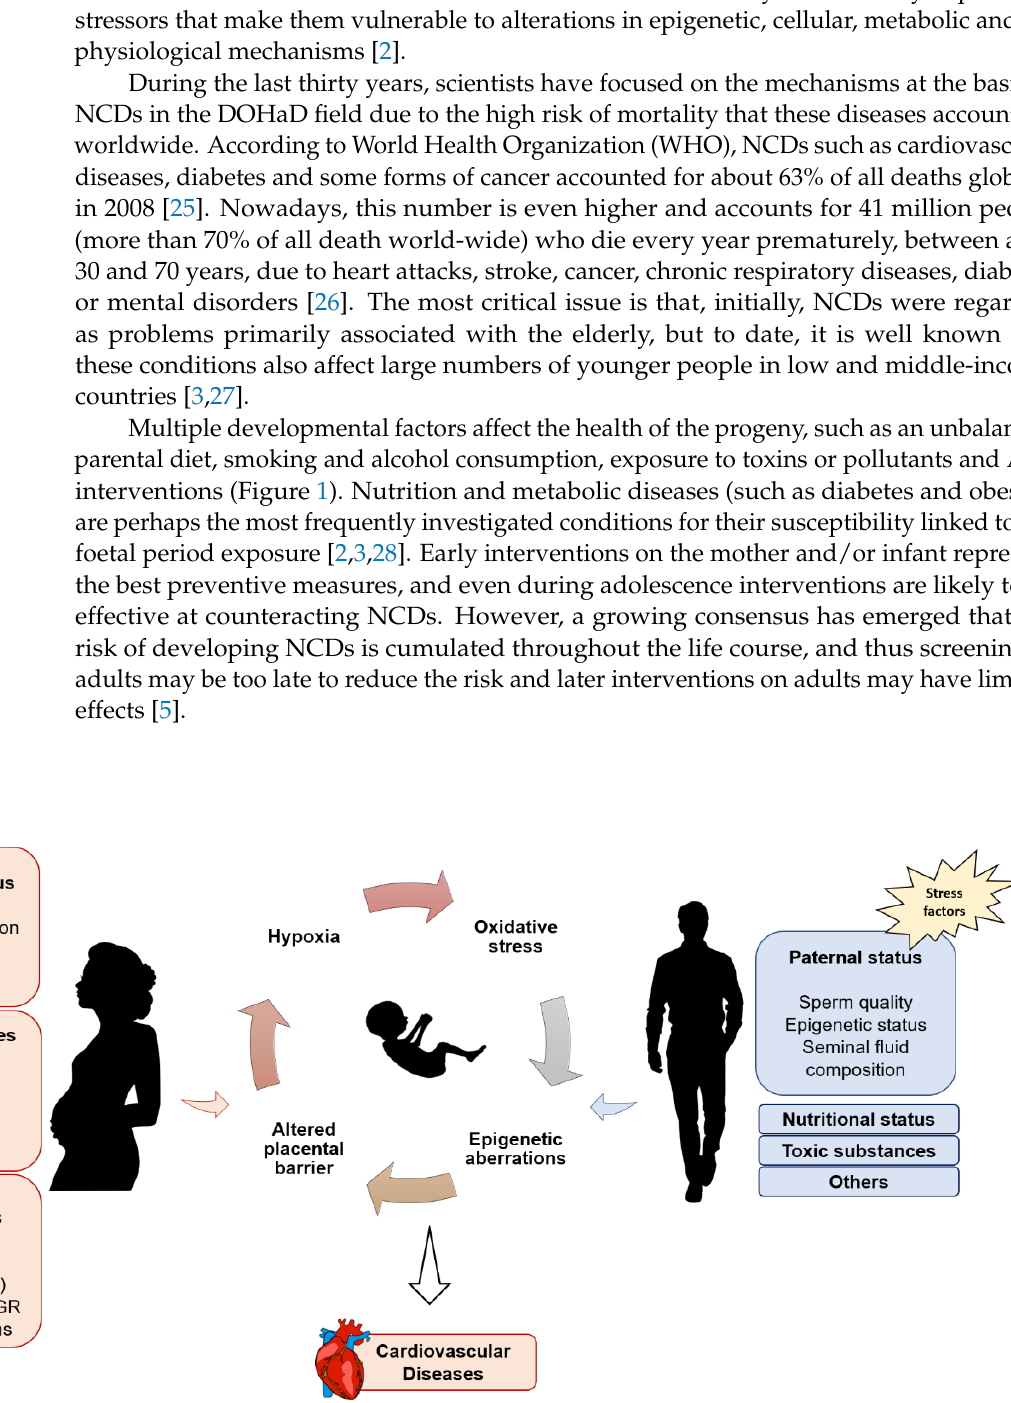
Figure 1. Maternal and paternal exposure to stress factors can perturb the foetal status and predispose to the onset of NCDs, such as cardiovascular diseases. Pregnancy environment contributes significantly to the newborn development, and numerous stressors have long-lasting effects on the health of the progeny. IUGR: intra uterine growth restriction, GDM: gestational diabetes mellitus.